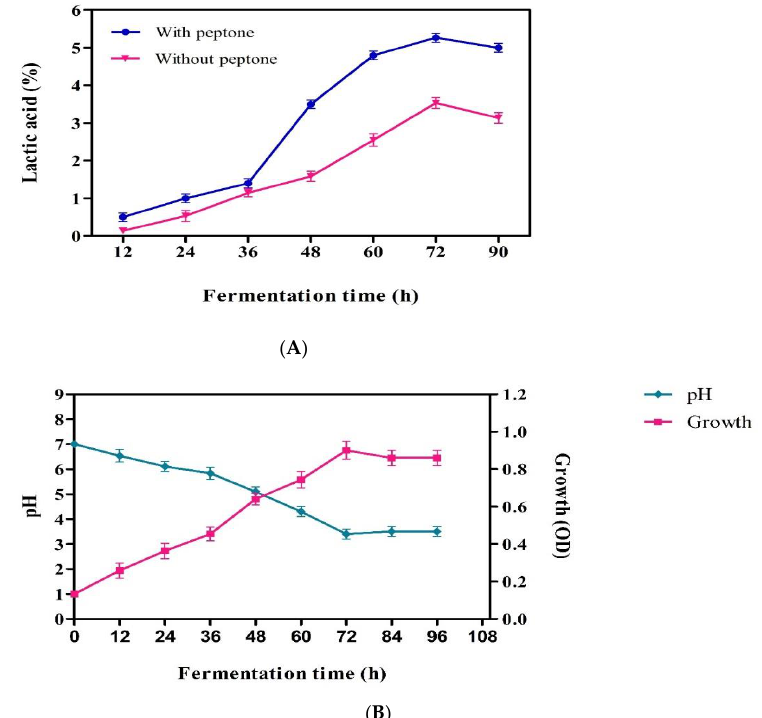
Figure 5. ( A ) Lactic acid production from mango peel by Pediococcus sp. HLV1; ( B ) pH and growth kinetics in lactic acid production from mango peel (peptone added) by Pediococcus sp. HLV1.